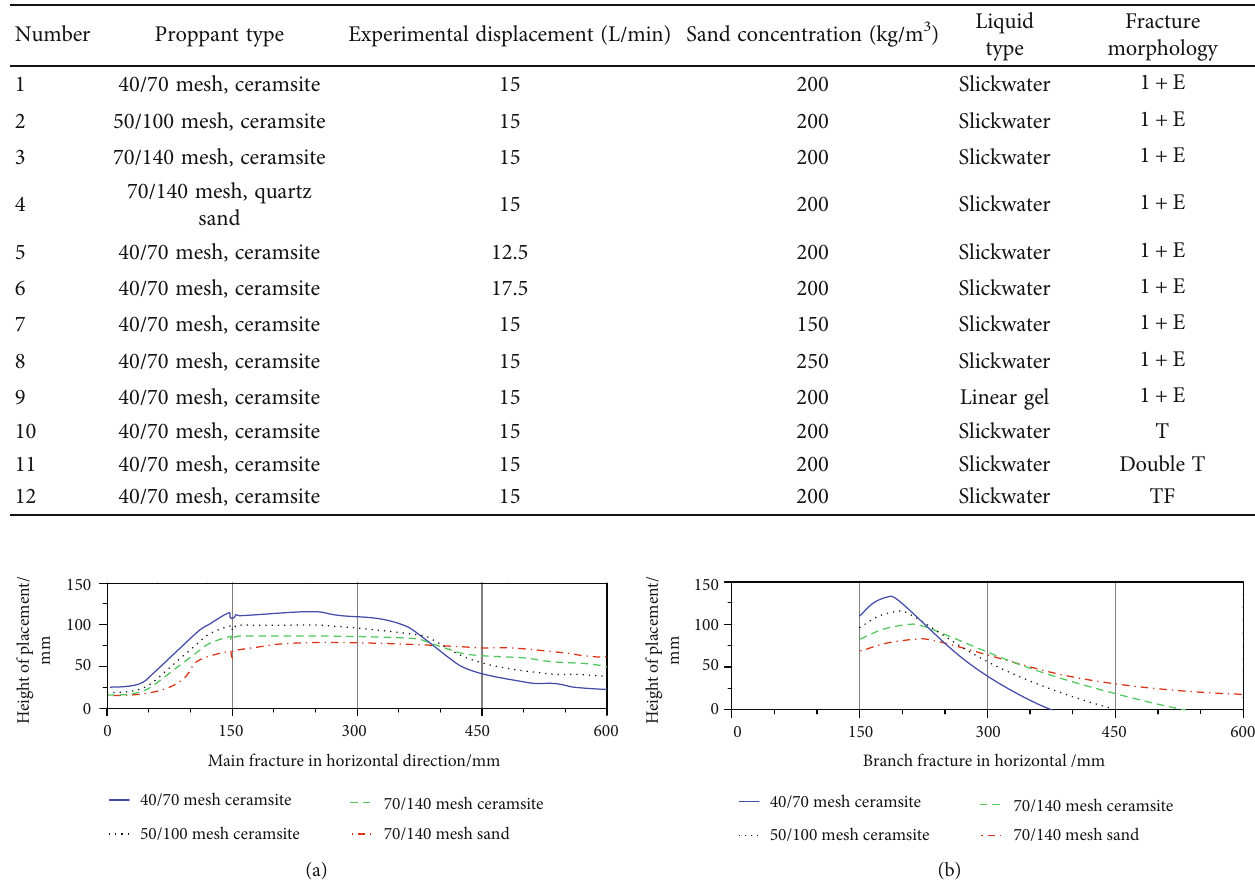
Table 2: Experimental scheme of proppant transport in complex fractures.